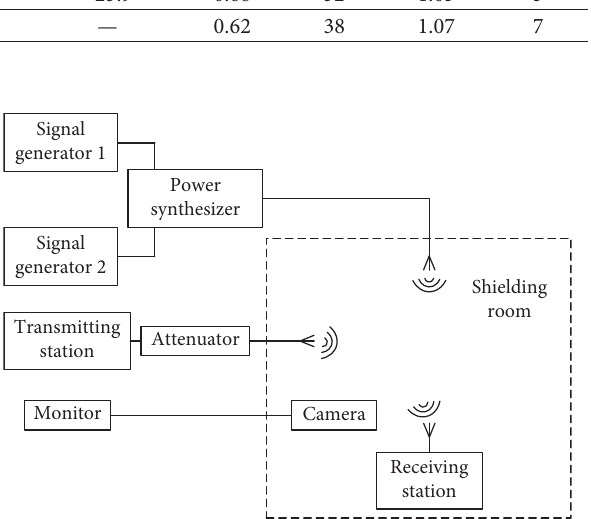
Figure 5: Layout of continuous wave electromagnetic radiation experiment on the communication